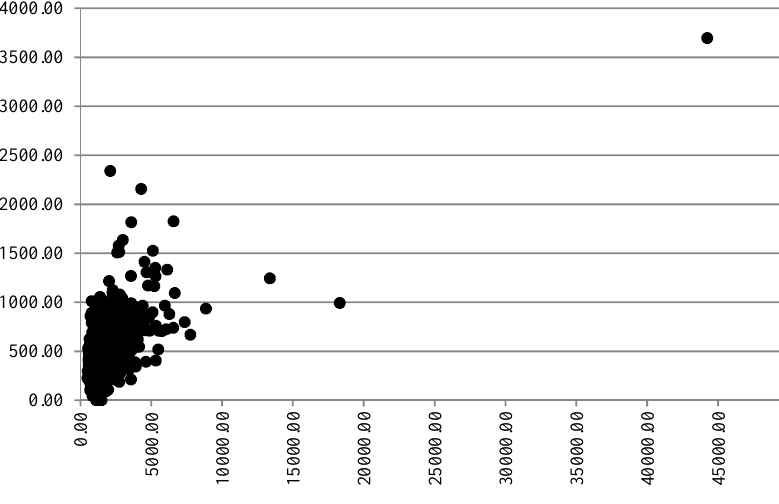
Figure 3. A scatter diagram for municipalities’ own revenue and local share of education funding (PLN per